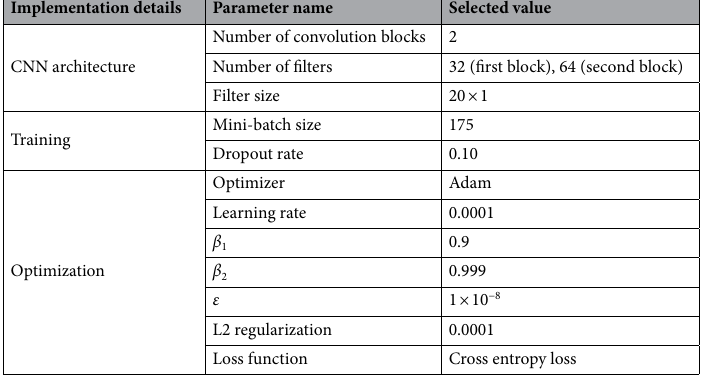
Table 1. CNN hyperparameters and training details.